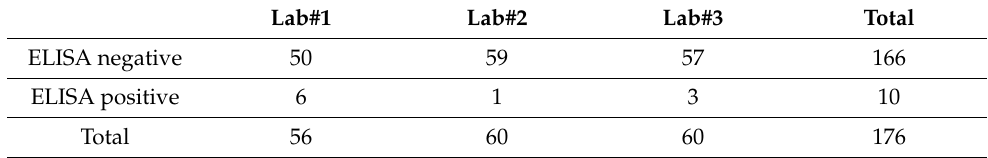
Table 4. Summary of ELISA results for Cryptosporidium spp. oocyst negative